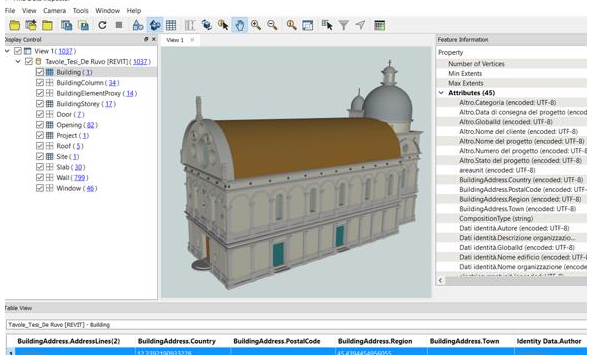
Figure 9. .rvz file in the FME Data Inspector and its elements subdivision and information.